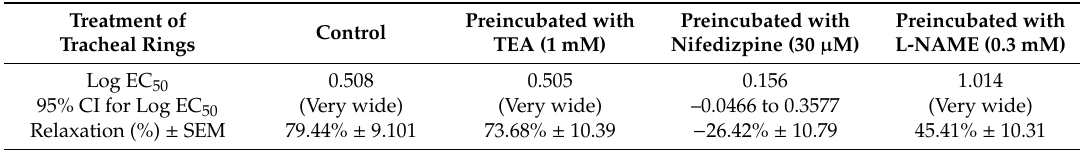
channel blockers, and with NG-nitro-L-arginine methyl ester (L-NAME),